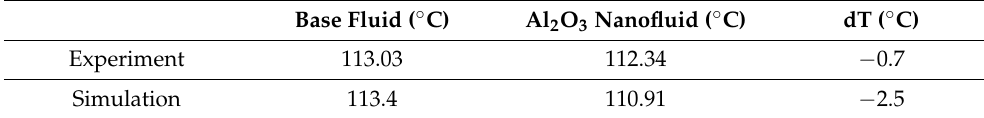
Table 4. Oil temperature variation results at 2500